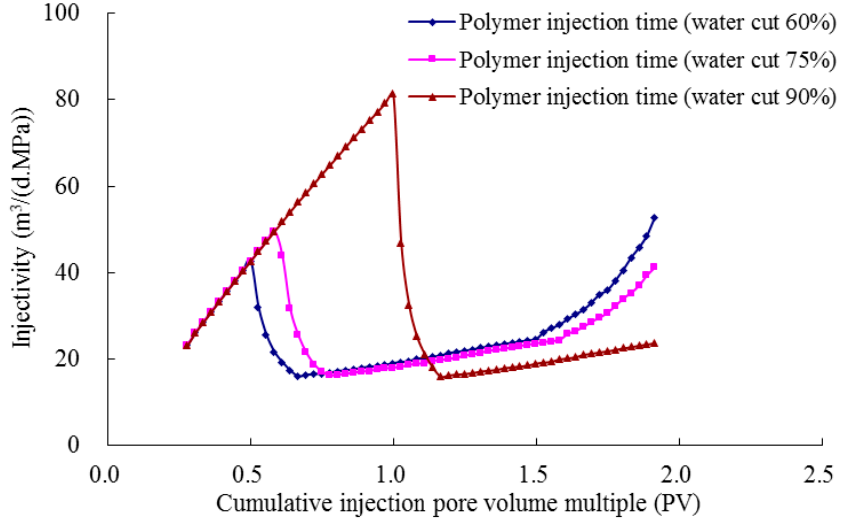
Figure 10. The influence of polymer injection time on injectivity.